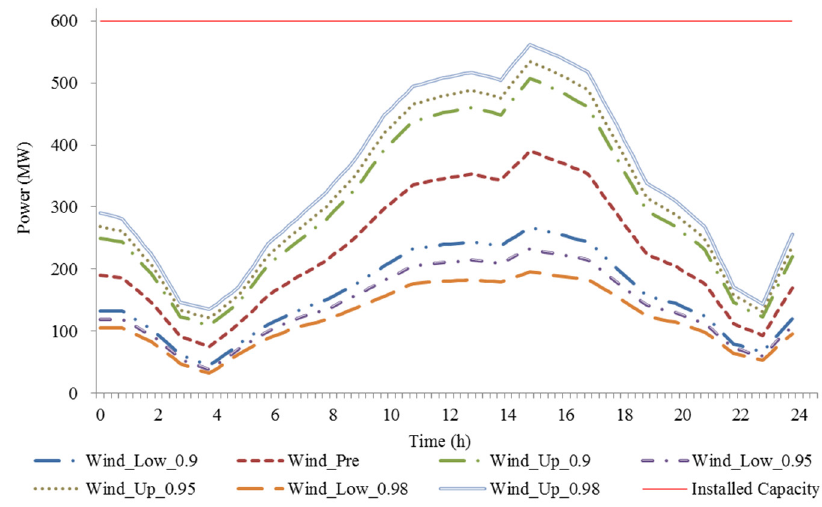
Figure 8. Predicted wind power and wind power bounds at different confidence degrees.